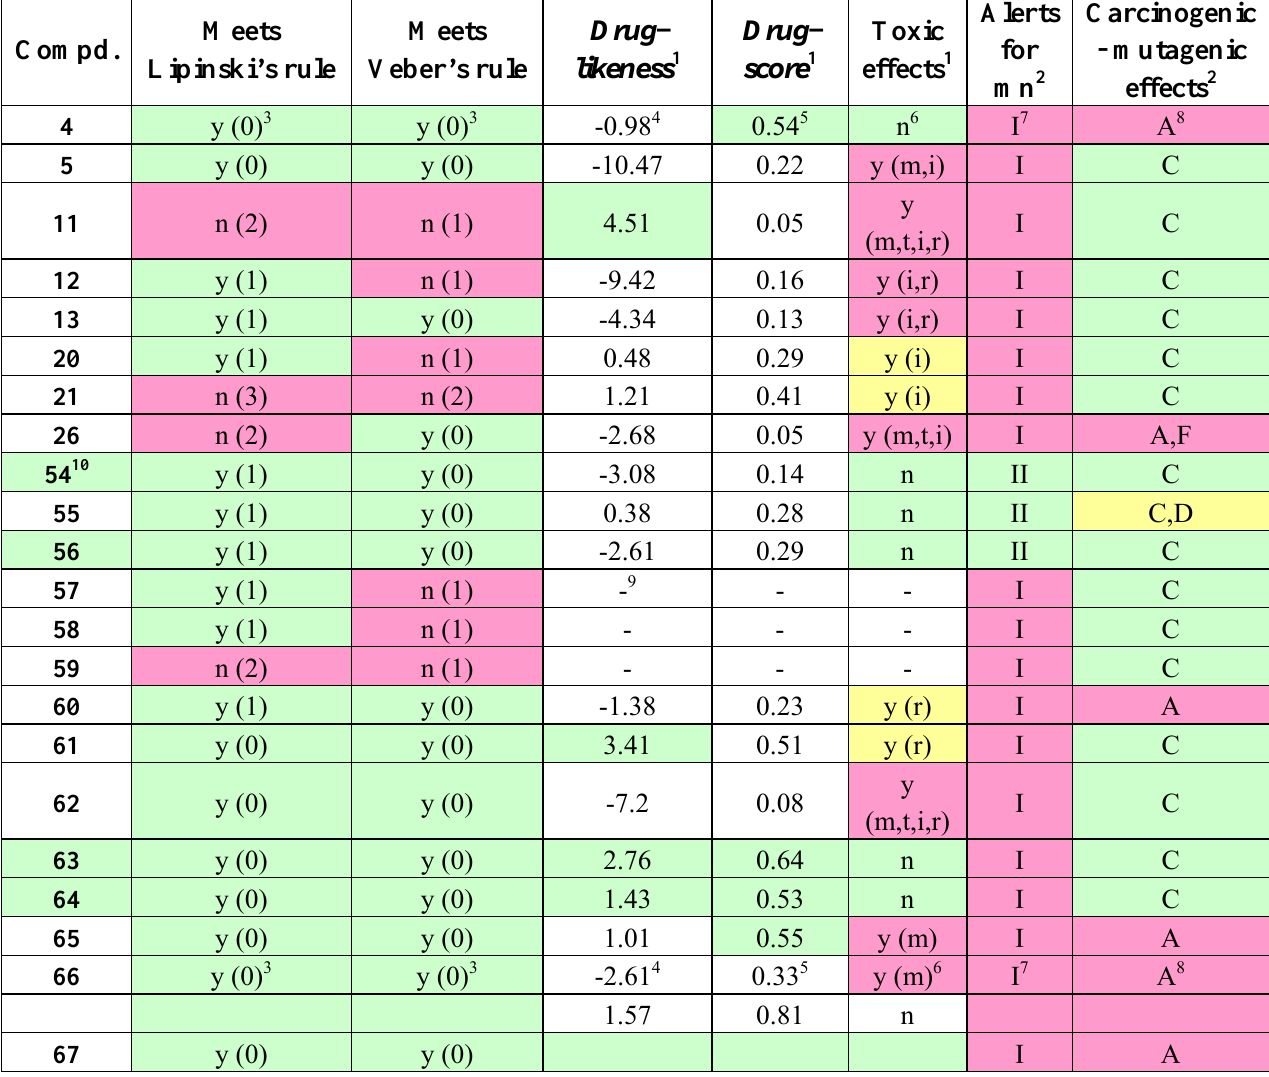
Table 1. Drug-like properties of compounds described in Section